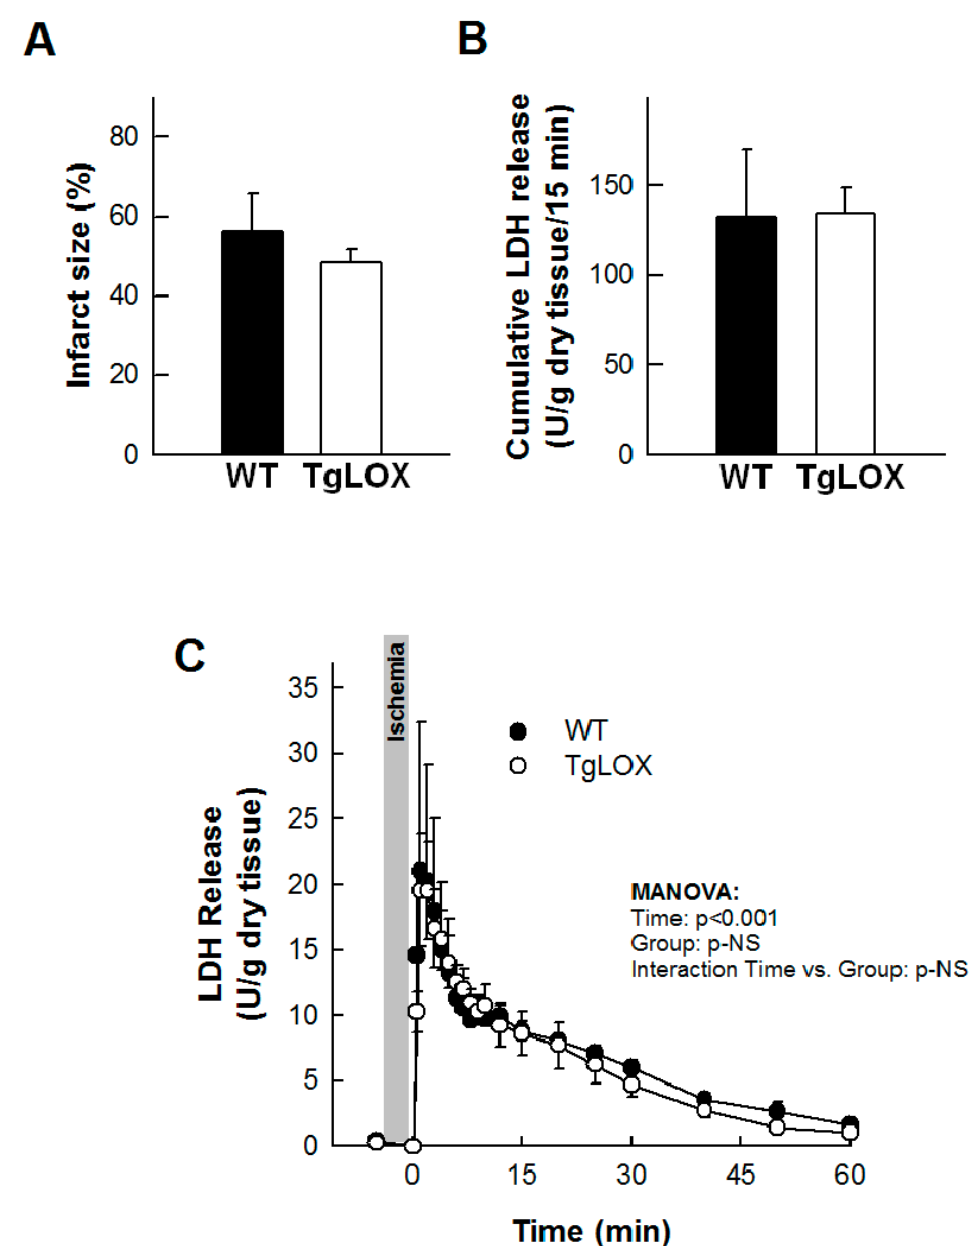
Figure 3. Ischemia-reperfusion injury in isolated mice hearts from wild-type (WT) and TgLOX ani- mals ( n = 5/group). No differences were observed between both groups in infarct size (( A ); Student’s t -test), cumulative lactate dehydrogenase (LDH) release during the first 15 min of reperfusion (( B ); Student’s t -test) or LDH release during the whole reperfusion period (( C ); MANOVA). Data are expressed as mean ± SEM.